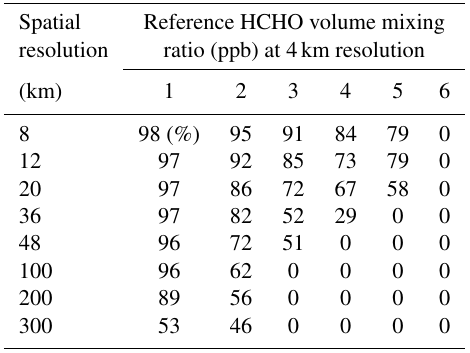
Table 1. Percentage (%) of intense HCHO plumes retained as the spatial resolution is changed from 4km. Each column shows the fraction of the plumes retained at coarser resolutions. Here the plume is defined by the area in which the HCHO mixing ratio is greater than the reference HCHO volume mixing ratio (VMR) (1– 6ppb) at 4km resolution. For example, the second column shows how much area at 8–200km resolution has a HCHO VMR >1ppb when compared with the area with VMR >1ppb at 4km resolu- tion. Similarly, the last column shows how often a model HCHO VMR is greater than 6ppb at 8–200km resolution compared with the same plume of VMR >6ppb at 4km resolution; all coarser res- olutions (8–200km) fail to capture this most intense plume. Only model HCHO results at 200m above ground level at 19:00UTC (12:00PDT) are used. The areas with HCHO VMRs greater than 1, 2, 3, 4, 5, or 6ppb are 92800, 29136, 12832, 4256, 848, or 64km 2